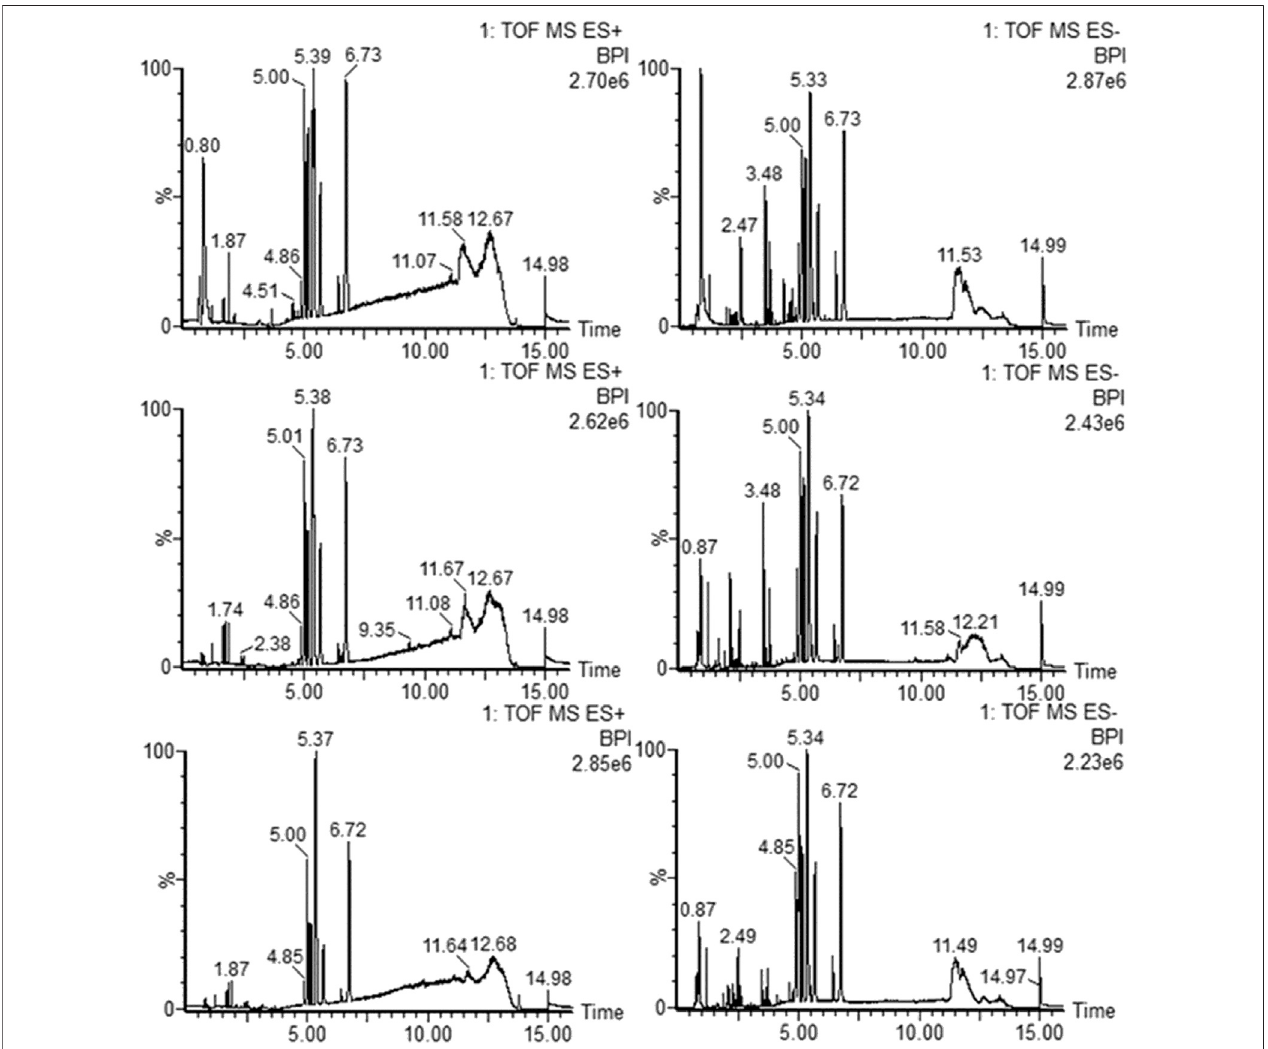
FIGURE 1 | Typical base peak intensity (BPI) chromatograms for serum samples obtained in ESI positive (A – C) and negative (D – F) modes based on UPLC/TOF- MS: control group (A, D) , Shi group (B, E) , and Xu group (C, F) .